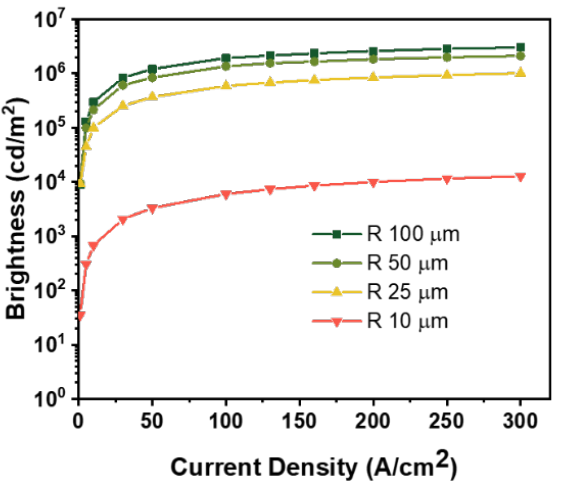
Figure 8. Brightness as a function of current density for different sizes of red QD micro-LEDs.